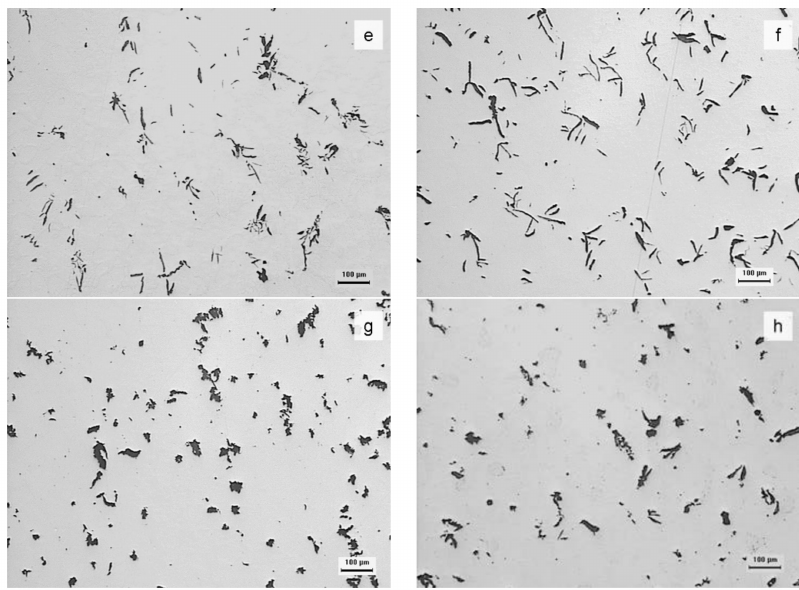
Figure 1. Selected light optical micrographs of the mid-section or working zone (zone II and/or zone III) of the ring roll layers for each experiment in the DOE analysis: ( a – h ), Experiment 1 to 8. Microstructures presented in the as-polished state.